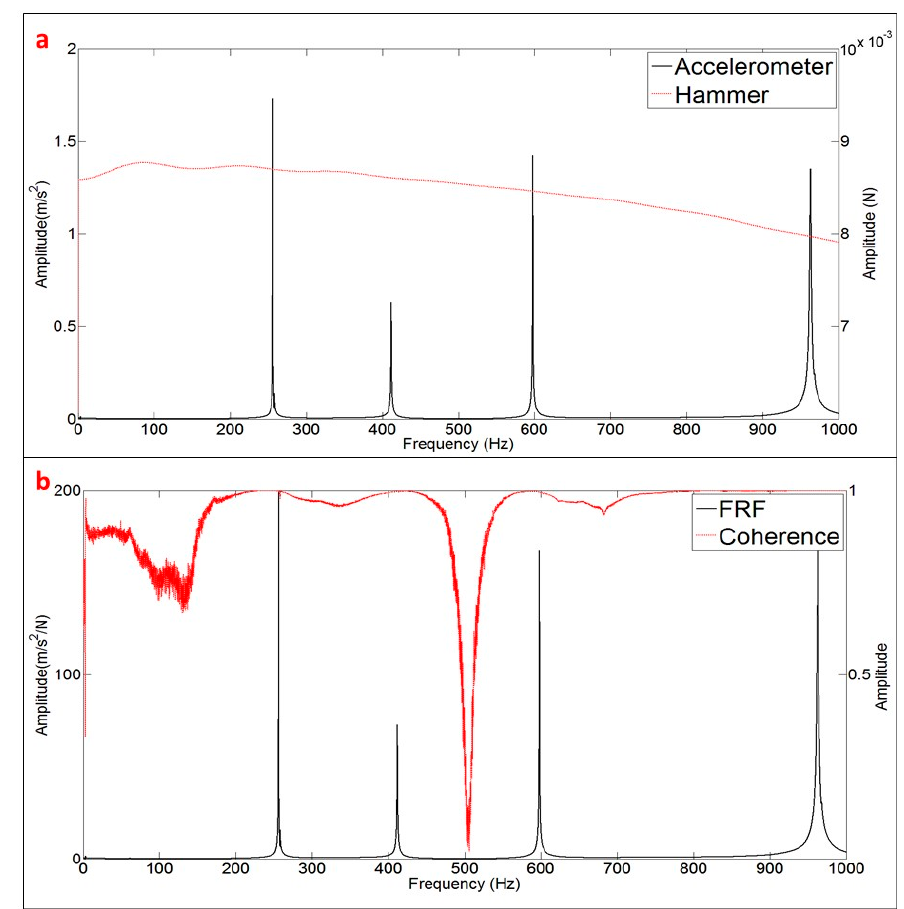
Figure 6. Obtaining the FRF: ( a ) One average of the frequency signals of Accelerometer and Hammer after applying the FFT; and ( b ) FRF estimated with 5 averages (impacts) and coherence.